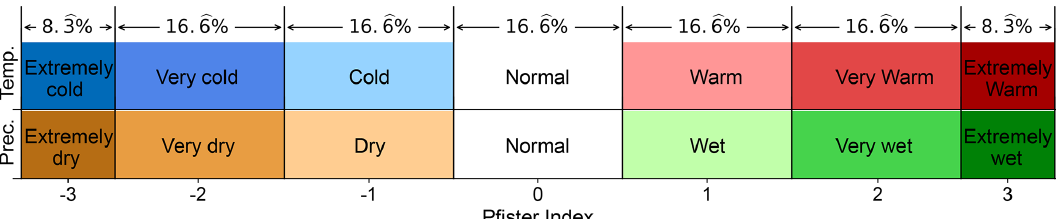
Figure 3. Pfister indices for temperature (top) and precipitation (bottom). Percentages show how climate information is distributed in terms of its severity. Note that Pfister indices classify temperature and precipitation values into 12 quantiles (or duo-deciles) with a uniform distribution of two duo-deciles for each index between − 2 and 2, while minimum and maximum indices (i.e., − 3 and 3) are associated with the lowest and highest quantiles,